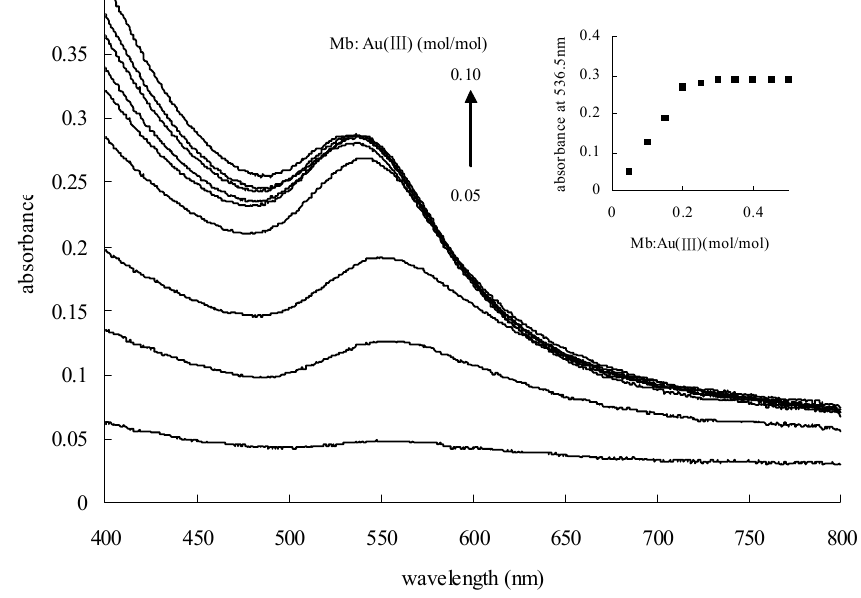
Figure 7. The effect of changing the ratio of Mb to Au (III) on the absorbance of gold nanoparticle solution. Solution containing 0.50 mM HAuCl varying amounts of Mb.